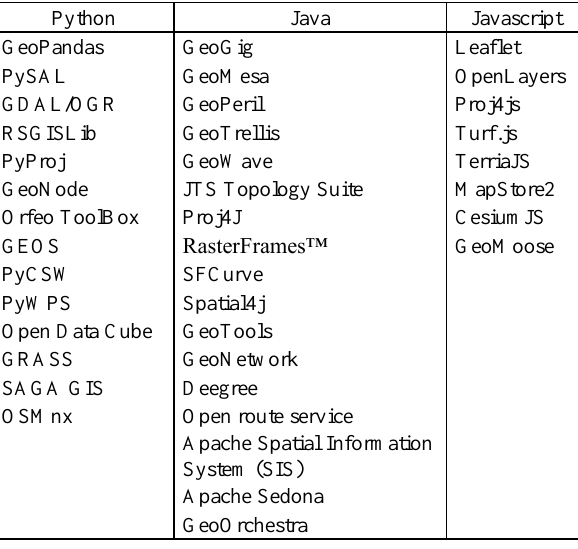
Table 2 . List of open-source geospatial